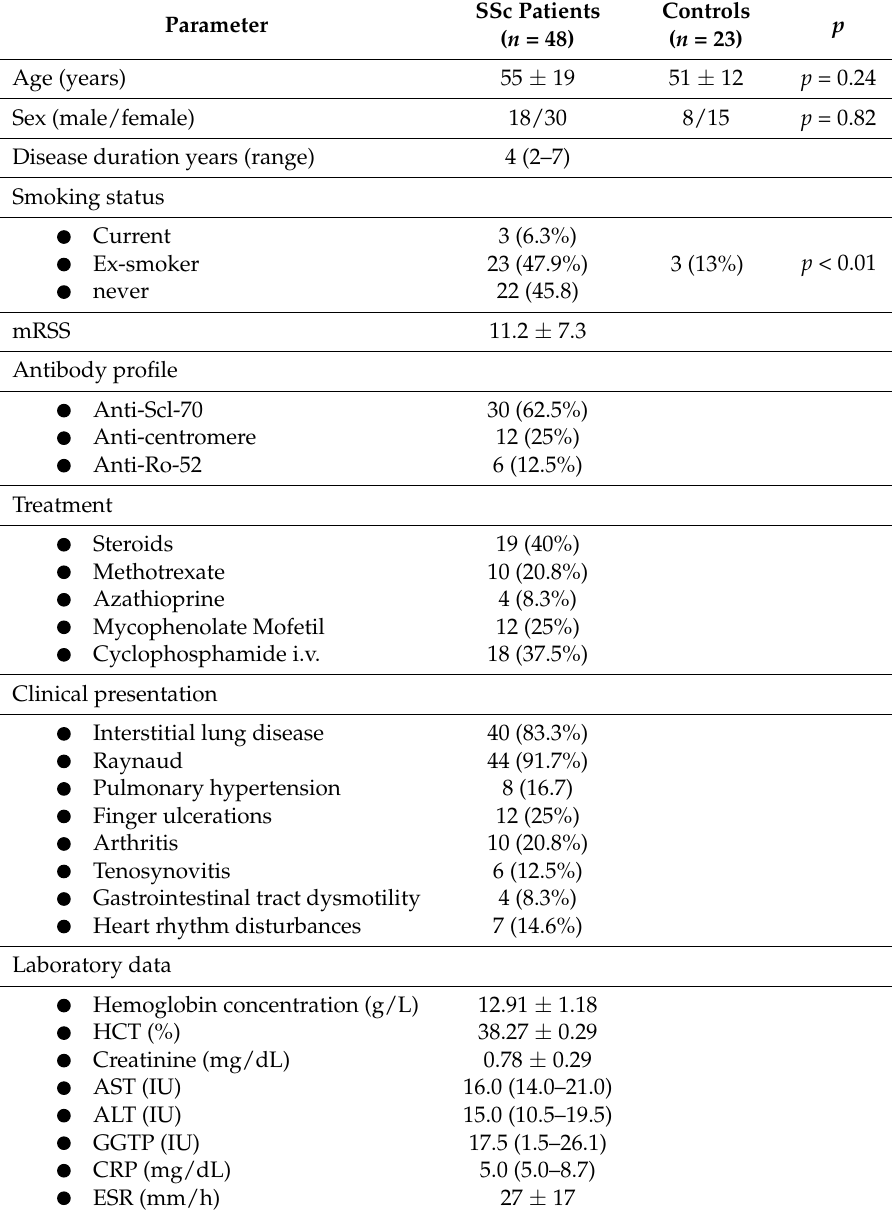
Table 1. Clinical characteristics of patients with systemic sclerosis and control